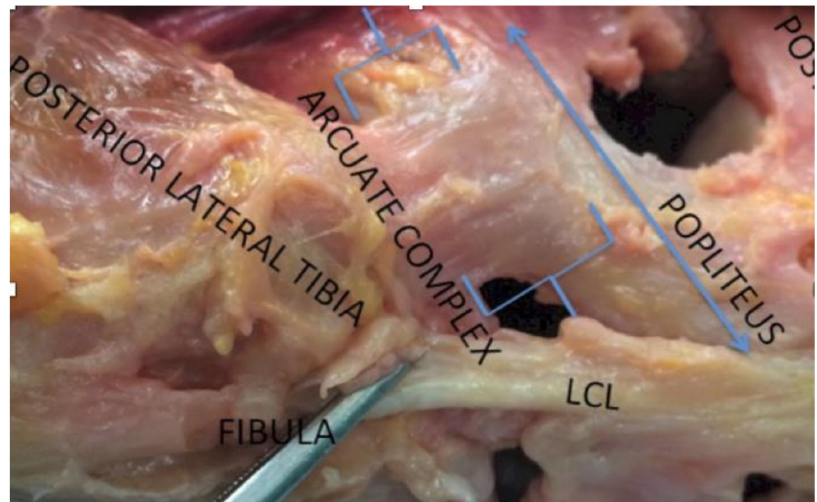
Figure 1. Posterolateral corner of the knee showing the arcuate